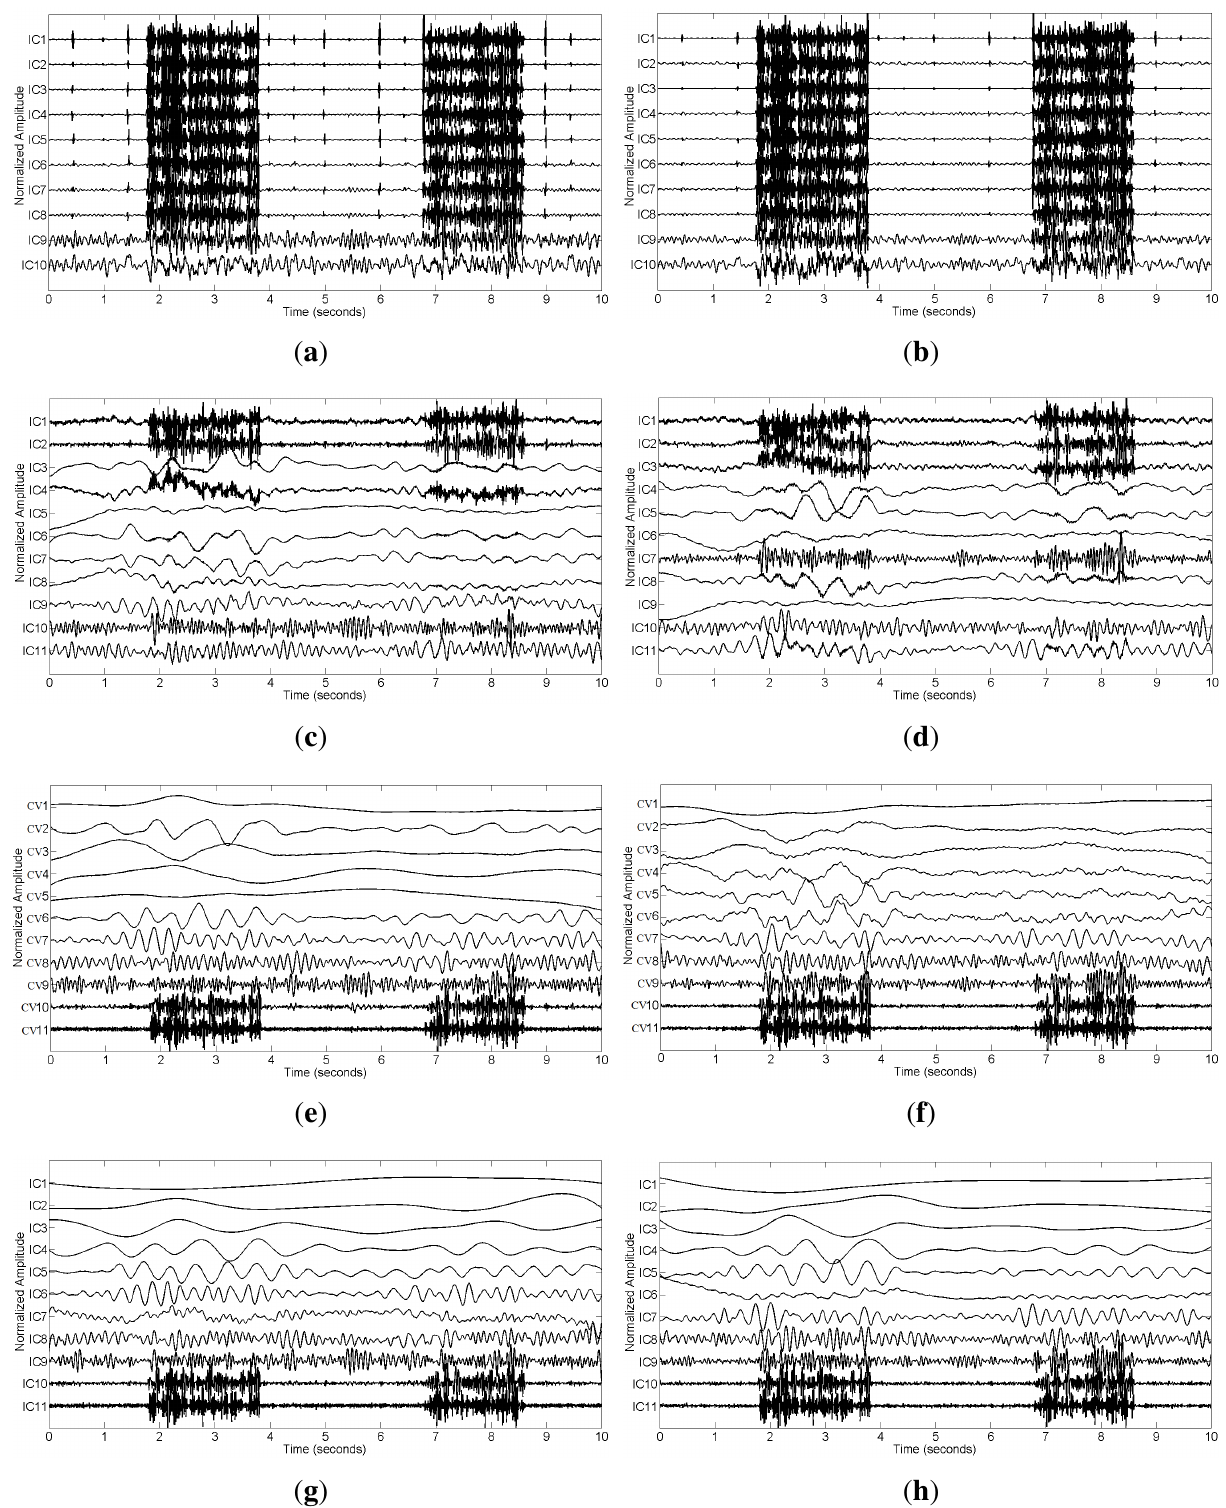
Figure 3. The decomposition components of the synthetic data x obtained using single-channel ICA (SCICA), EEMD-ICA, EEMD-canonical correlation analysis (CCA) and EEMD-independent vector analysis (IVA) at two different SNR values: ( a ) SCICA at ε = 2 (SNR = 0.7611); ( b ) SCICA at ε = 5 (SNR = 0.3044); ( c ) EEMD-ICA